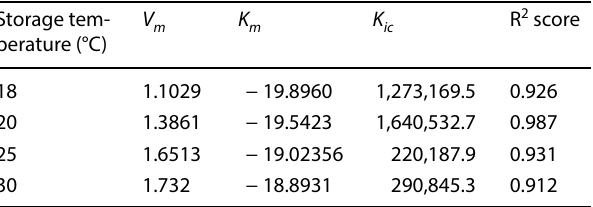
Table 1 MM equation coefficients calculated at 18 °C, 20 °C, 25 °C and 30 °C Storage tem- perature (°C)